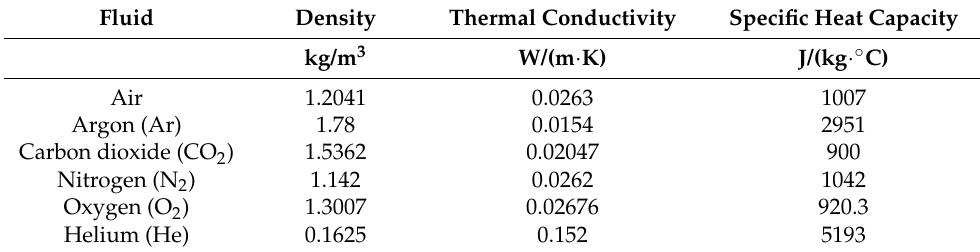
Table 2. Thermal properties of gases considered in this study.